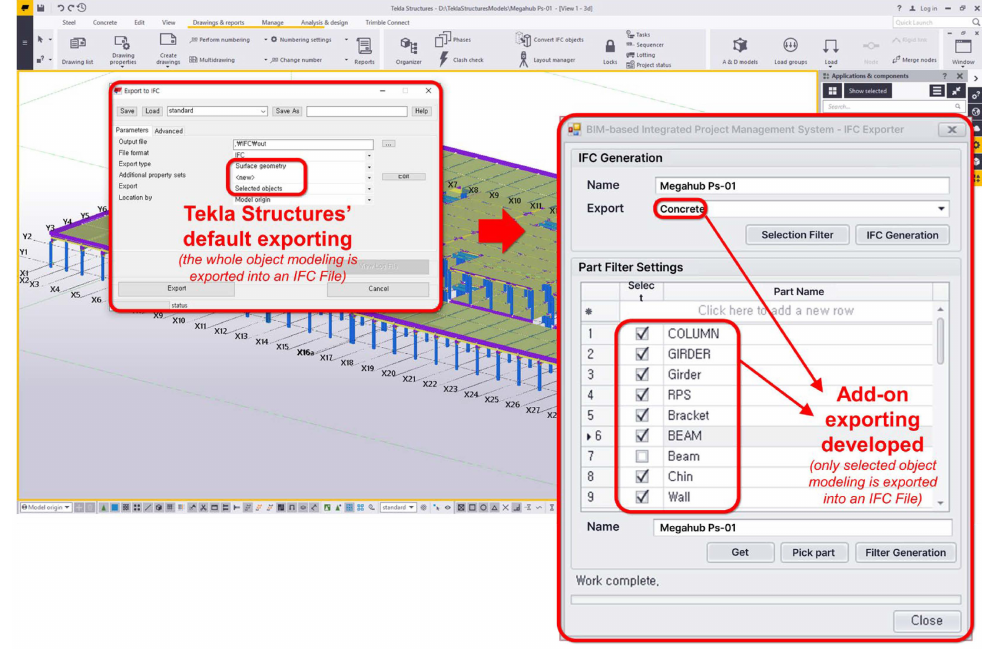
Figure 3. BIM-based object filtering when exporting to